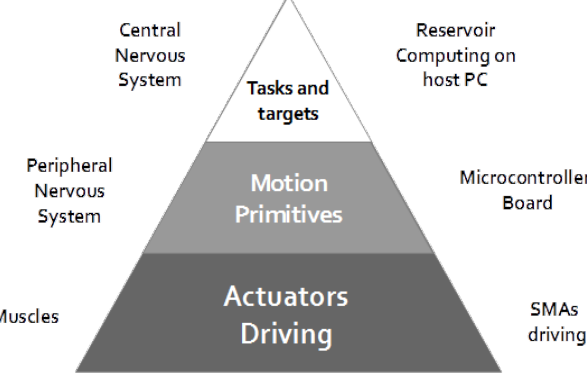
Figure 7. Hierarchal architecture with three abstraction